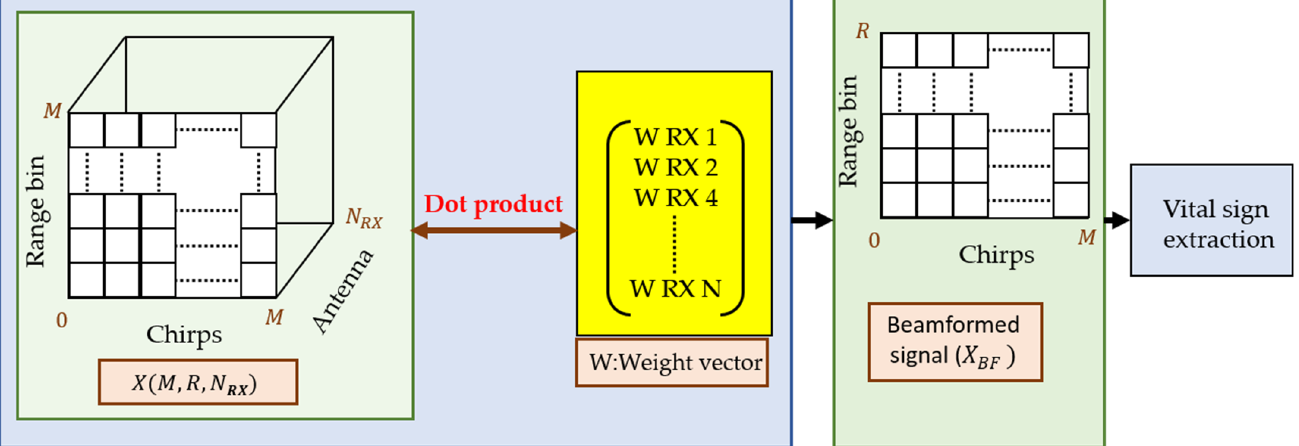
Figure 5. Beamforming operation: data from multiple receivers is multiplied with a weight vector to obtain a unified signal.